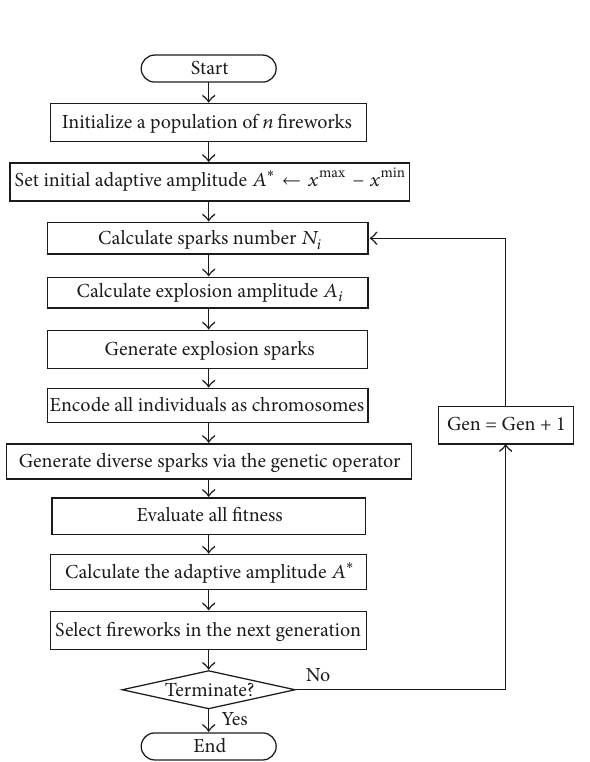
Figure 7: The flowchart of hybrid